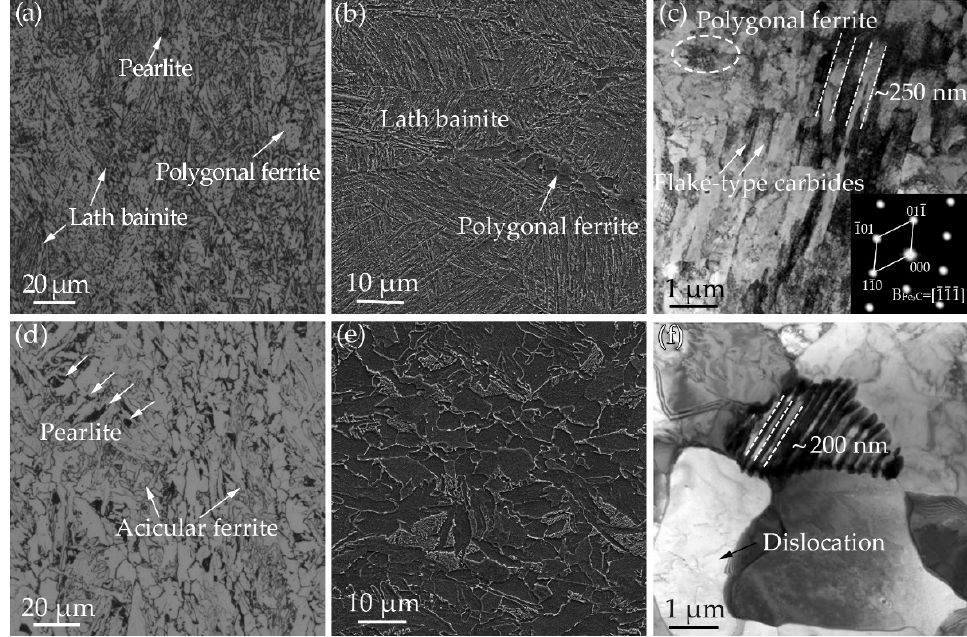
Figure 2. ( a , d ) OM images; ( b , e ) SEM images and ( c , f ) TEM images of the specimens obtained from surface and mid-thickness of in steel A plate.